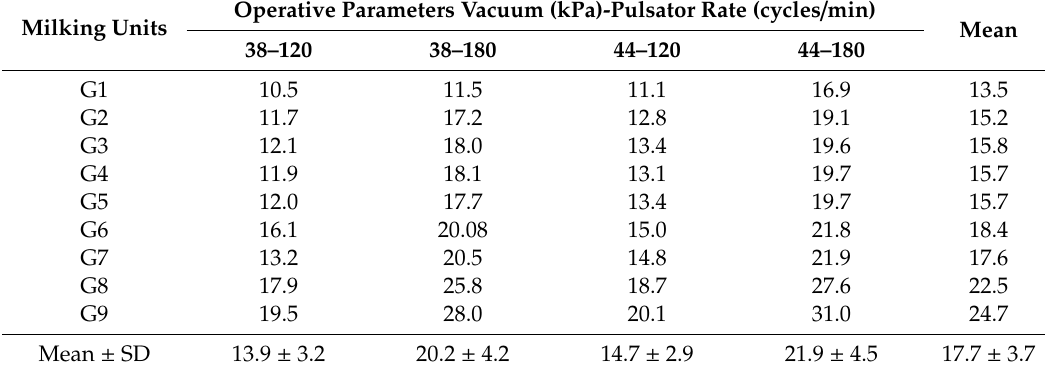
Table 2. Results obtained for each milking unit tested for phase ”a” length (%) at di ff erent operative vacuum levels and pulsator